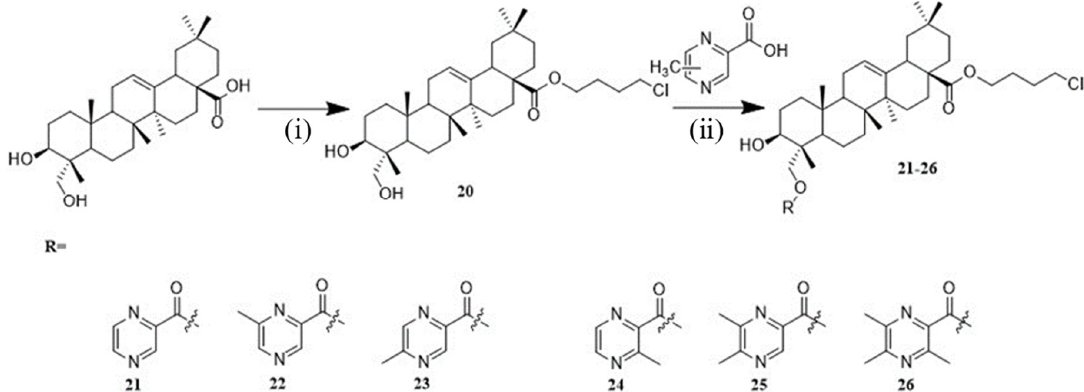
Scheme 4. Synthesis of He derivatives 20 – 26 . Reagents and conditions: ( i ) DMF, K 2 CO 3 , 4- chlorobutanol, 75 °C , 4 h, with 54% yield; ( ii ) CH 2 Cl 2 , EDCI, DMAP, rt, 12 h, with 30–90%